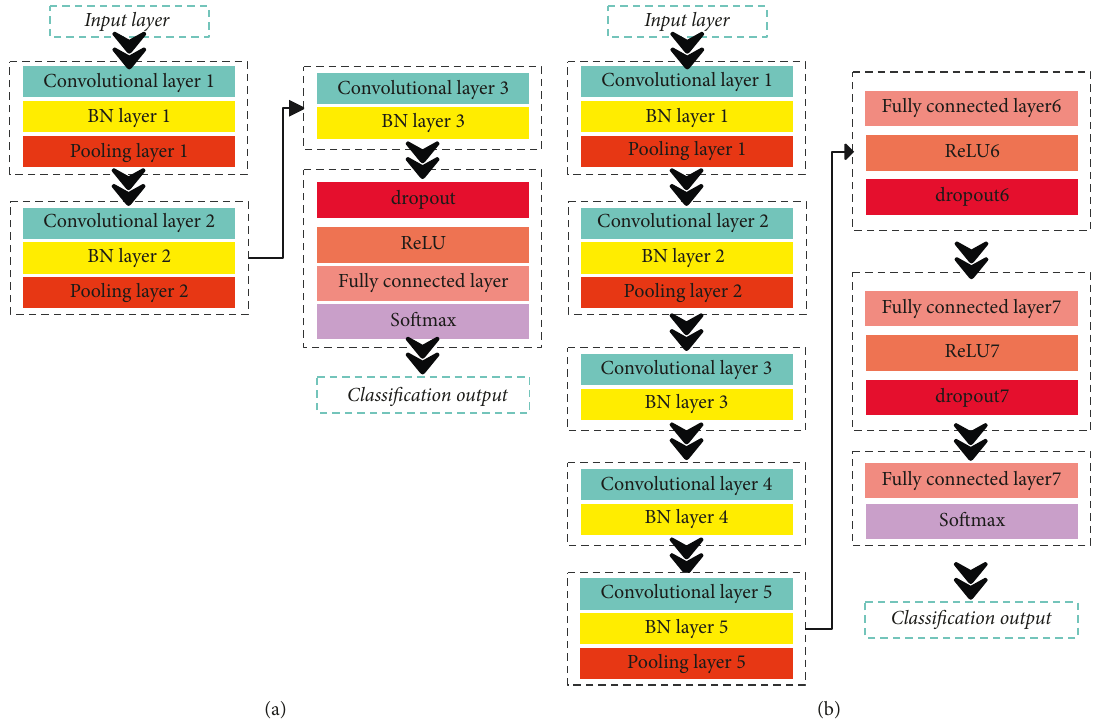
Figure 4: System network architecture diagram. (a) Cha network architecture, (b) AlexNet network architecture